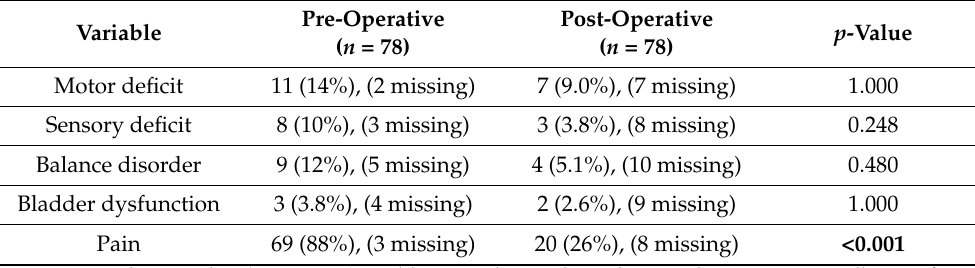
Table 5. Functional outcome: